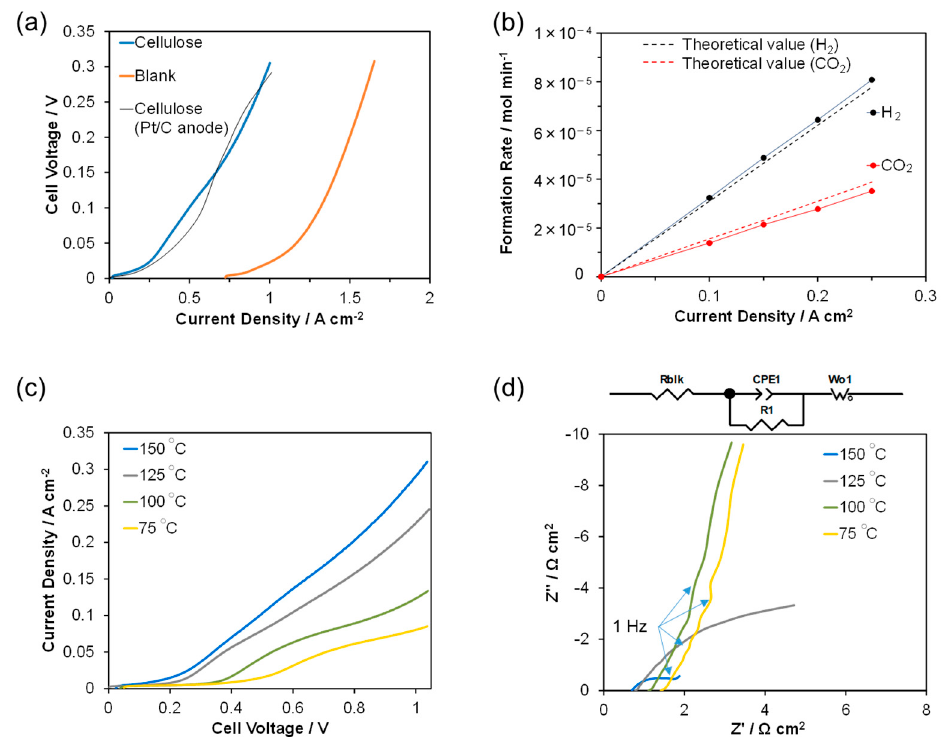
Figure 1. Characteristics for cellulose electrolysis of the cell using a partially oxygenated Ketjen Black (KB) anode and Pt/C cathode: ( a ) I–V curves at 150 °C with and without cellulose. Data for an electrolysis cell using a Pt/C anode and cathode are included for comparison. ( b ) Formation rates of hydrogen at the cathode and CO 2 at the anode. Theoretical values are shown by the dotted lines. ( c ) I–V curves and ( d ) Nyquist impedance plots between 75 and 150 °C.